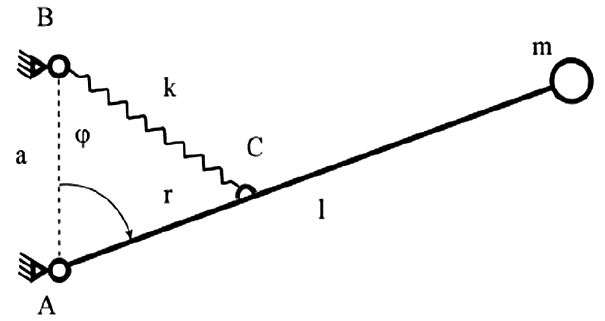
Figure 3. akr type spring gravity compensation mechanism, as in- troduced in Tuijthof and Herder (2000), reprinted with permission. Mass m , supported by bar l , acted on by gravity, g , can be exactly balanced at any point in its rotation about point A by a zero free length spring with stiffness k attached to ground reference at a ver- tical distance a , and at point r along bar l . For practical implementa- tions spring k either must act through some type of cable structure, to allow the approximation of zero free length, or some other me- chanical construct must be used to allow for zero free length approx- imation. The design of such structure can be non-trivial, especially in constrained